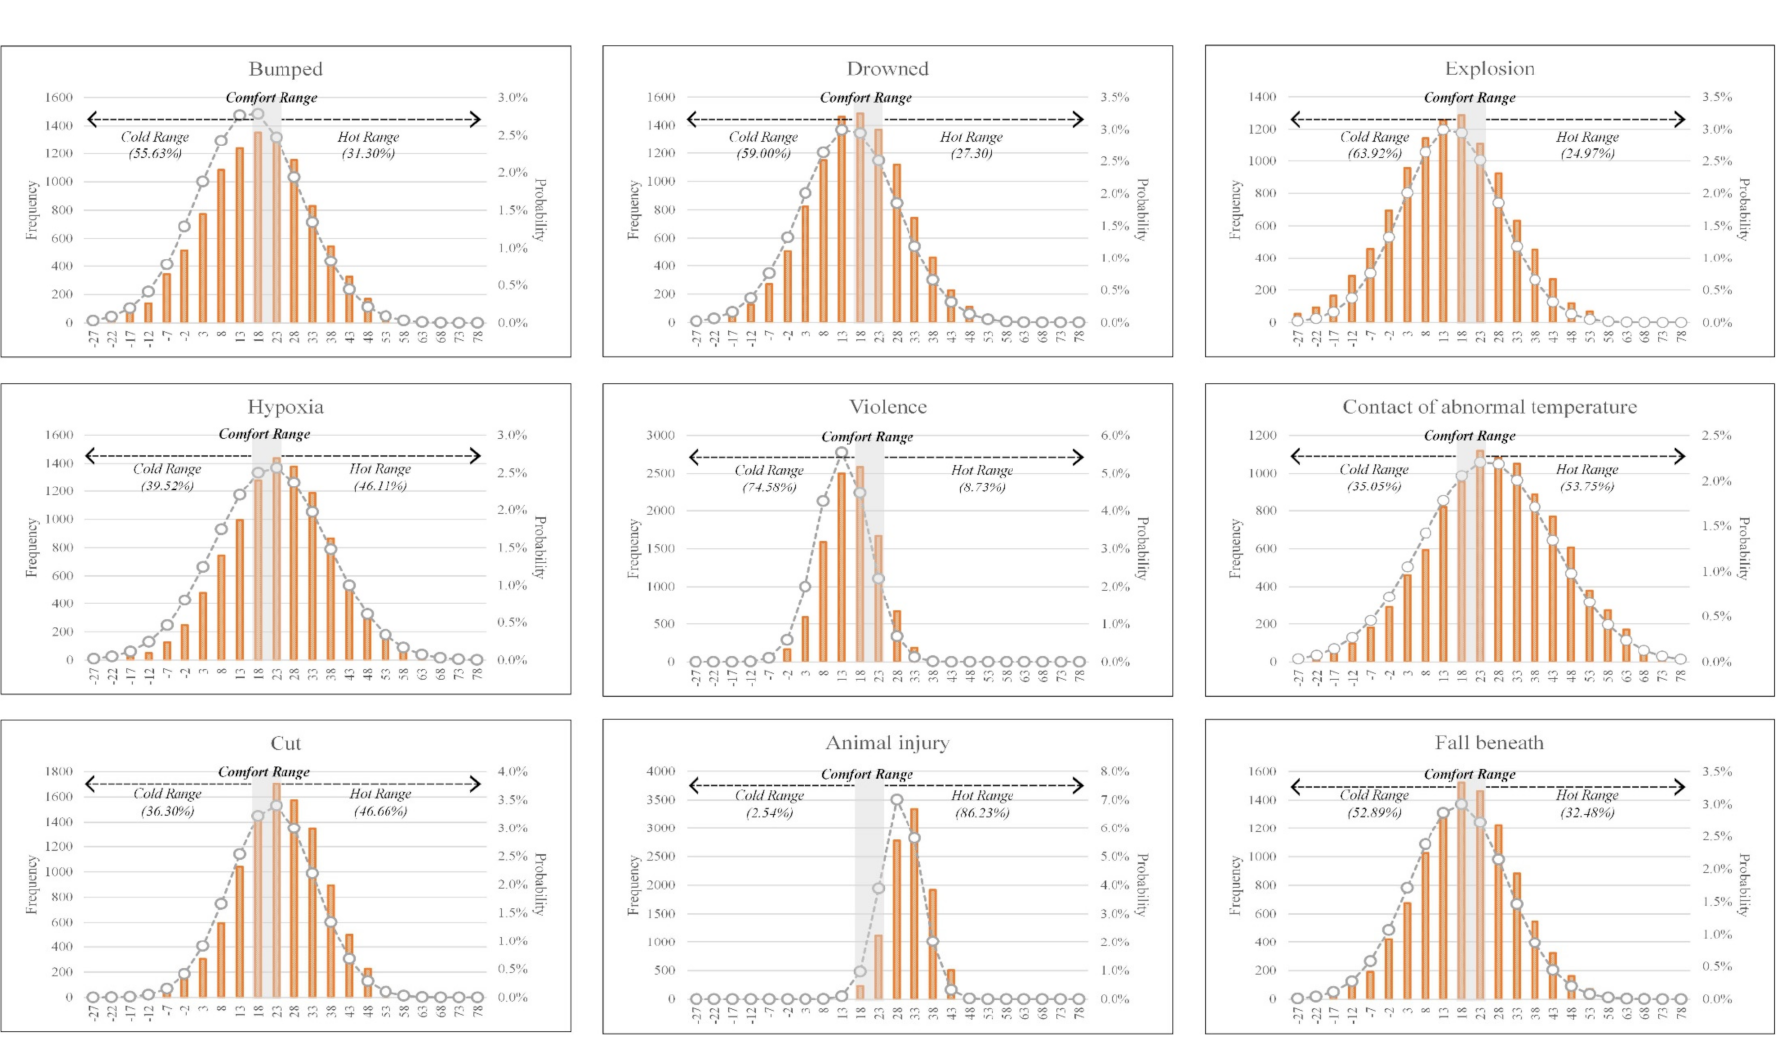
Figure 7. Analysis of the probability distribution of fatal accident using a Monte Carlo